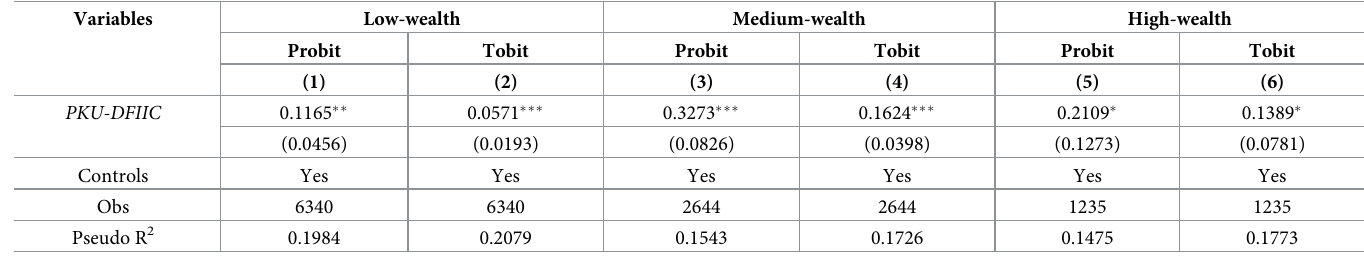
Table 4. Heterogeneity analysis 1: Household